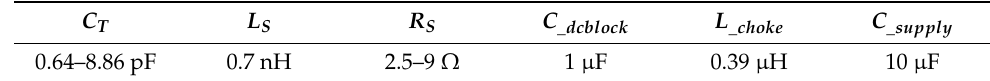
Table 5. Simulation—discrete component values.